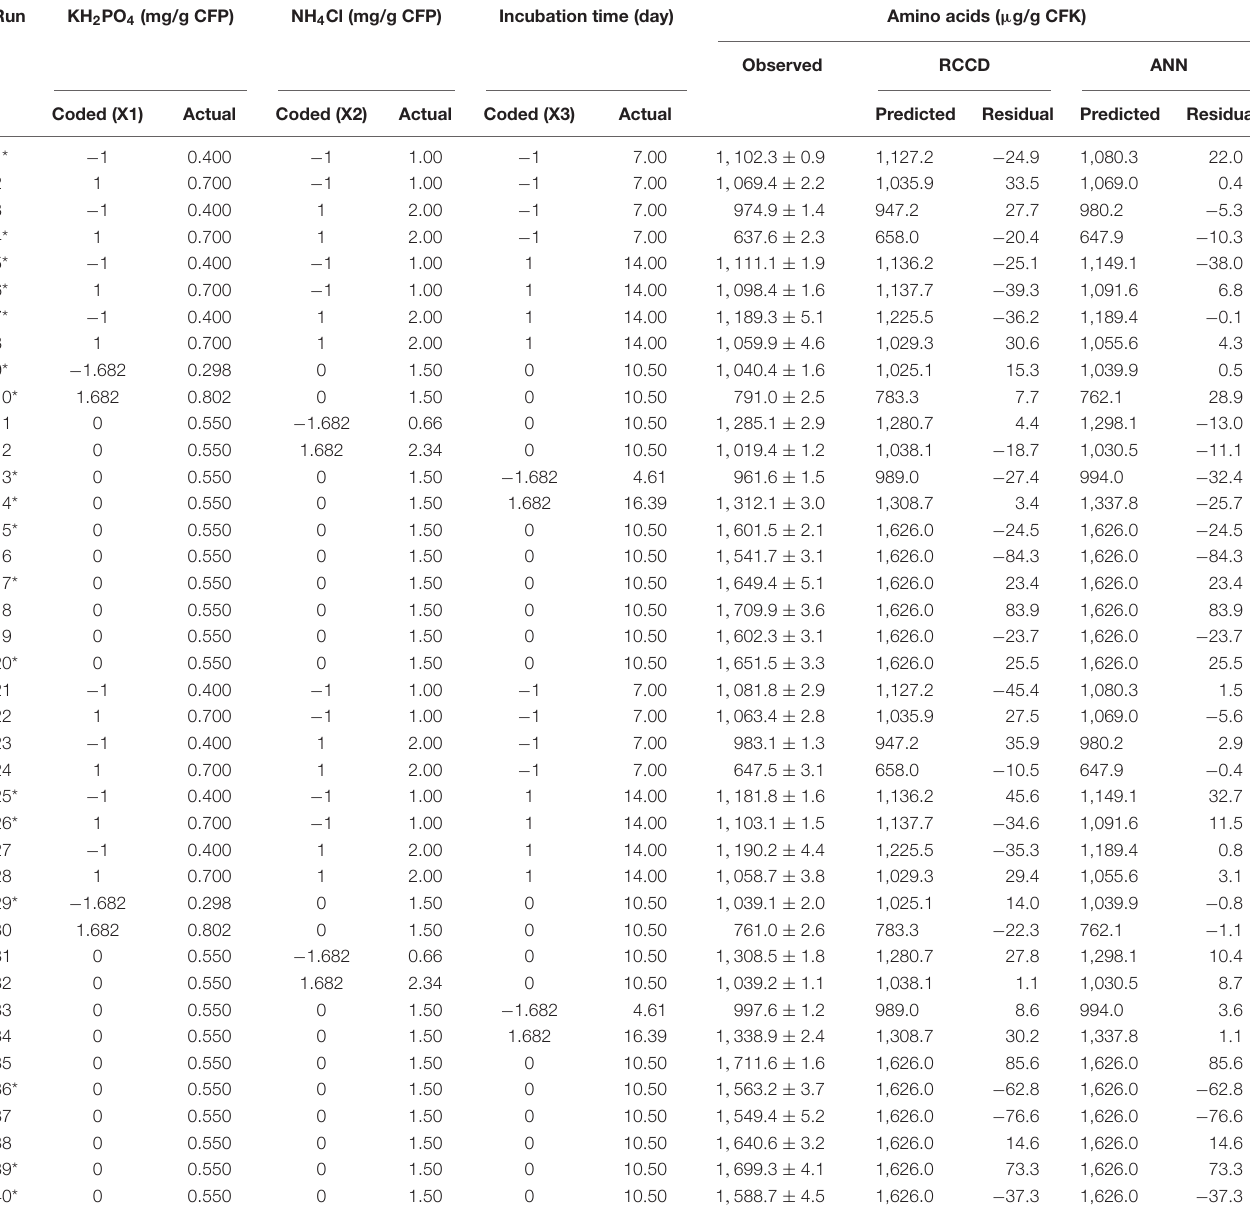
TABLE 2 | The RCCD matrix of the independent factors, showing the experimental data of amino acids production, and the corresponding predicted values obtained from RCCD and ANN models. Run KH 2 PO 4 (mg/g CFP) NH 4 Cl (mg/g CFP) Incubation time (day) Amino acids ( µ g/g CFK) Observed RCCD